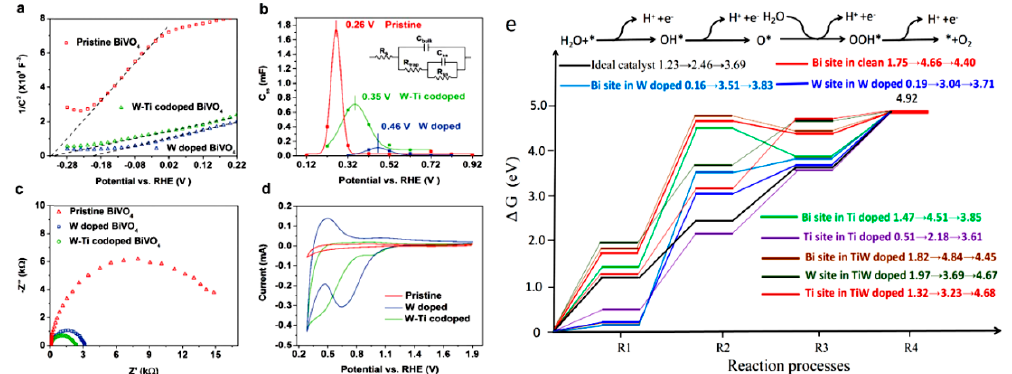
Figure 23. Electrochemistry results in 0.5 M Na 2 SO 4 aqueous solution under 1.5 G illumination ( a ) Mott-Schottky plots of pristine, W doped BiVO 4 and W–Ti codoped BiVO 4 at the frequency of 1 kHz; ( b ) C ss determined from EIS (rectangle points). Inset is the equivalent circuits employed to fit the experimental EIS data; ( c ) EIS of pristine, W doped, and W–Ti codoped BiVO 4 photoelectrodes at the applied potential of 1.23 V RHE; ( d ) Cyclic voltammetry scan of pristine, W doped and W–Ti codoped